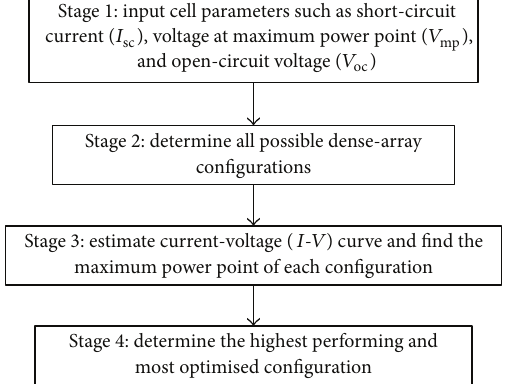
Figure 2: A detailed description showing all four stages of FPM.